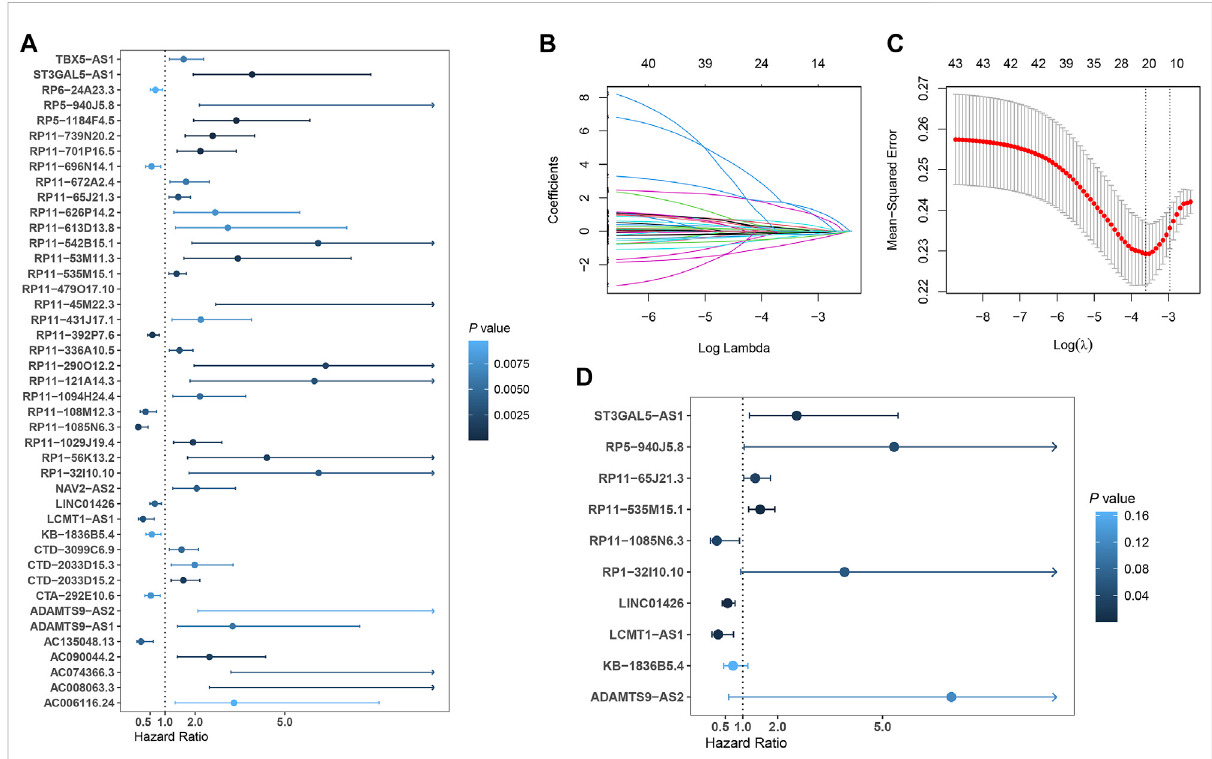
FIGURE 2 Development of prognostic ferroptosis-related lncRNAs signature for LUSC patients; (A) Forest plot of the 43 selected lncRNAs signi fi cantly associated with overall survival by univariate Cox regression analysis; (B) The coef fi cient pro fi le of 21 OS-related lncRNAs chosen by LASSO regression; (C) The mean-squared error curve with different tuning parameters (log λ ) and perpendicular dotted lines were drawn at the log λ corresponding to the minimum mean squared error (lambda.min) and the most regularized model within one standard error of the minimum mean squared error (lambda.1-se); (D) Forest plot of the 10 fi nal selected lncRNAs by multivariate Cox regression